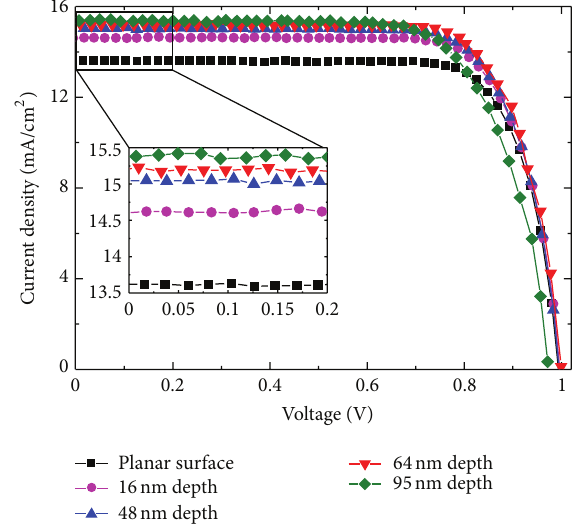
Figure 4: EQE of the solar cells with and without the nanohole arrays.